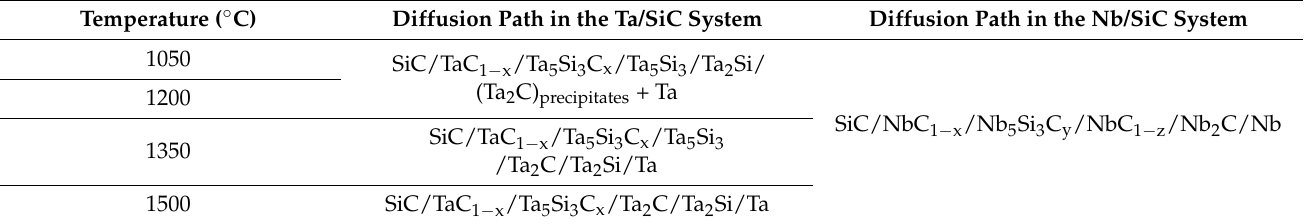
Table 5. Diffusion paths in the Nb/SiC and Ta/SiC systems as a function of the